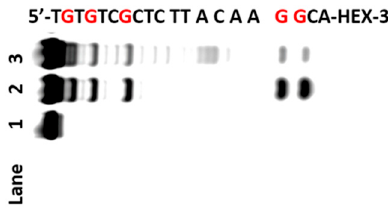
Figure 5. Polyacrylamide gel electrophoresis analysis of 20 mer-DNA. Lane 1: DNA alone; Lane 2: DNA was treated with AP; Lane 3: DNA was treated with methylene blue in the presence of light and oxygen for 15 min.